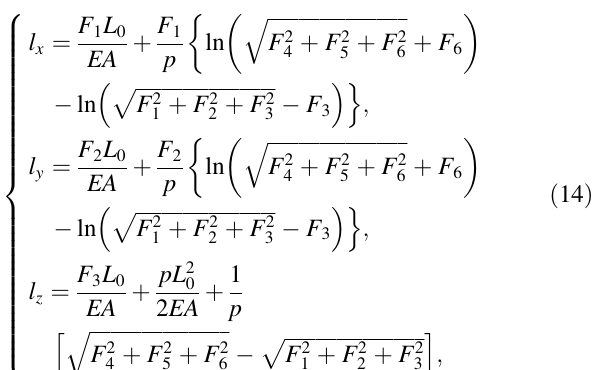
F 2 þ F 2 þ F 2 1 2 3